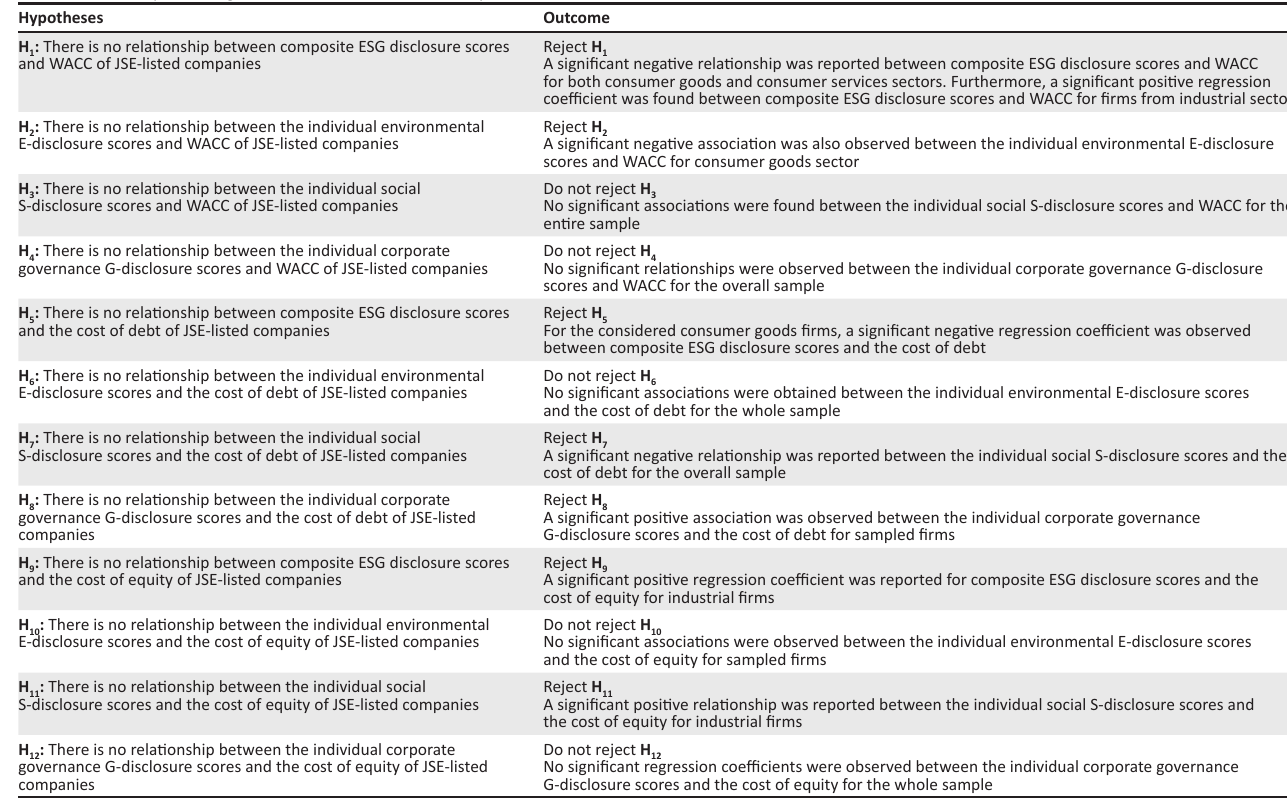
TABLE 8: Summary of the significant results of statistical analyses. Hypotheses